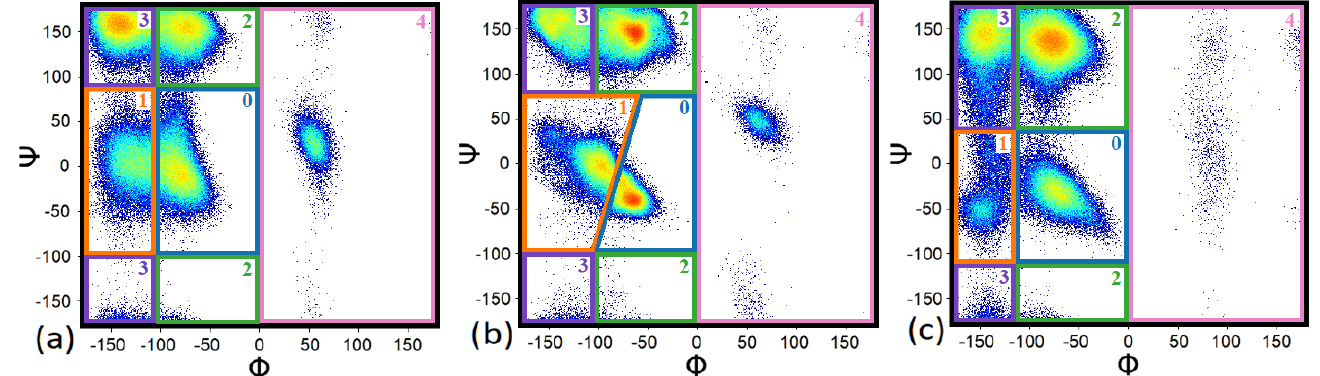
Figure 3. The integration regions of Ramachandran maps for PASA with Na+ using ( a ) FF99SB- ILDN, ( b ) C27 (also C22 and C36m), and ( c ) OPLS/AA force fields. The color boxes show the areas of dihedral angles related to the conformations: (0, α R helix for C27 and also for FF99SB-ILDN and OPLS/AA), (1, 3.10 helix for C27 and additional screw conformation for FF99SB-ILDN and OPLS/AA), (2, PPII helix), (3, β -sheet), and (4, φ > 0°—mostly left handed α -helix).